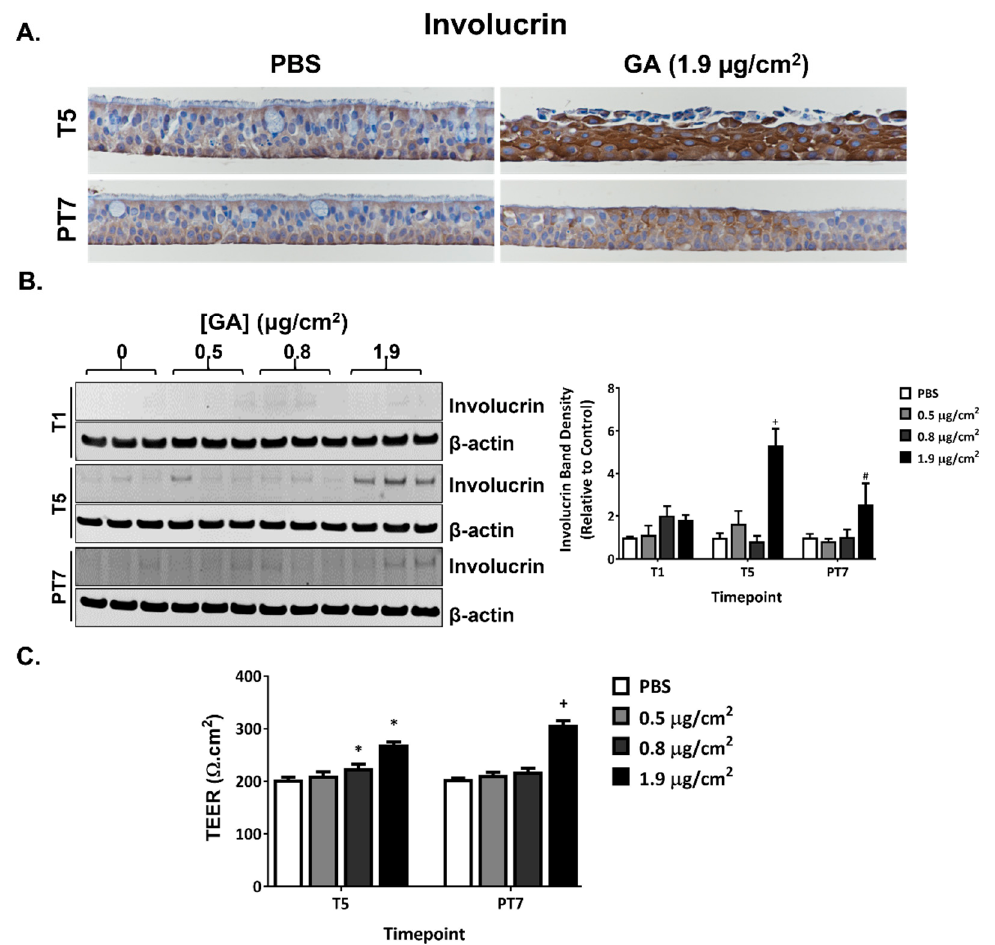
Figure 7. Squamous differentiation induced by GA aerosols in ALI cultures. ( A ) Induction of squamous differentiation was assessed by IHC staining with involucrin antibodies at T5 and PT7. Representative images were captured at a magnification of 40 × . ( B ) The expression of involucrin was quantified at T5 and PT7 by immunoblotting. Representative blots were presented in the left panel. The quantification of the relative expression of involucrin is shown on the right panel. ( C ) TEER was measured at T5 and PT7. Data ( n = 3) are presented as means ± SEM. * ,+,# p < 0.05 was considered statistically significant compared to the respective vehicle controls.